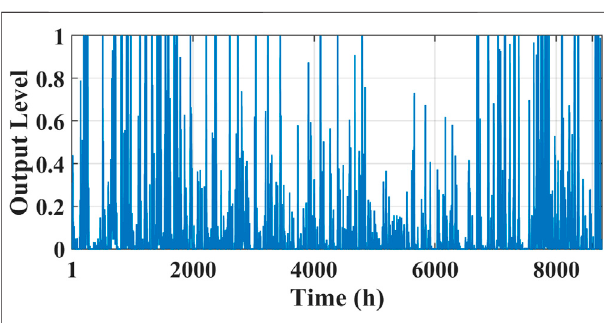
FIGURE 7 | WT annual